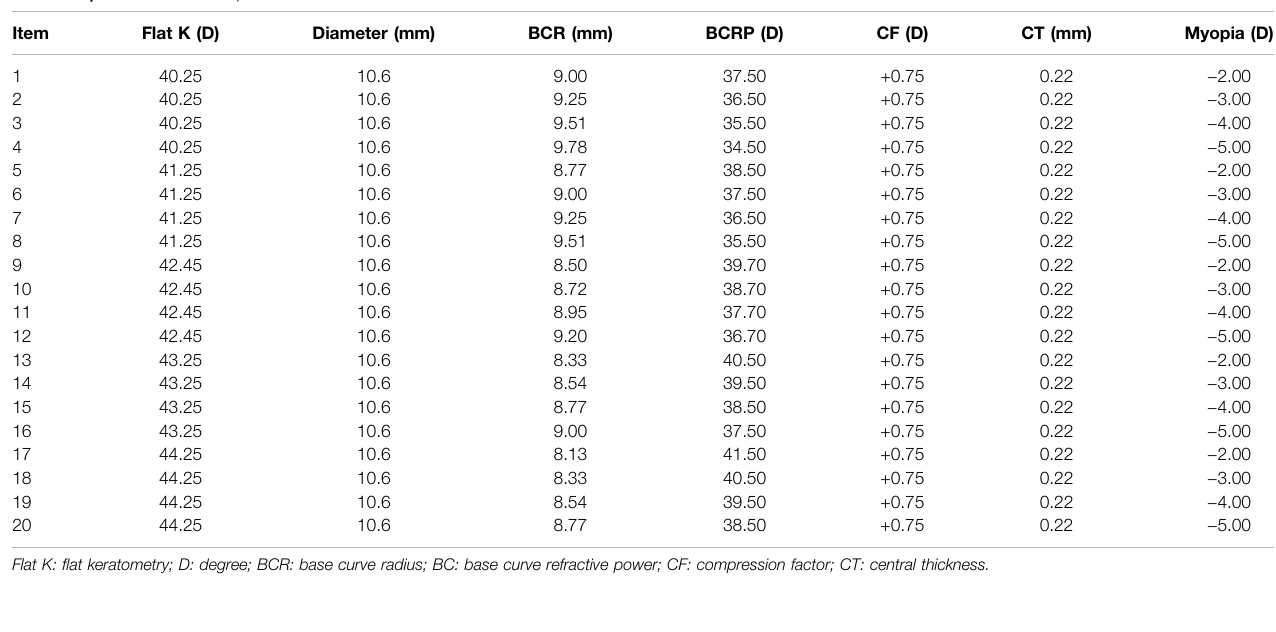
TABLE 2 | The selected lens parameters.